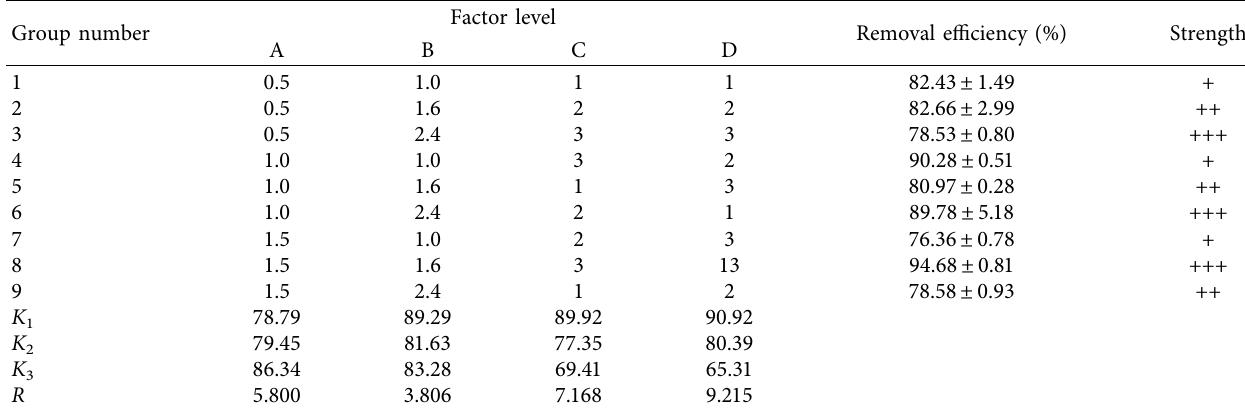
Table 2: Orthogonal experimental results.